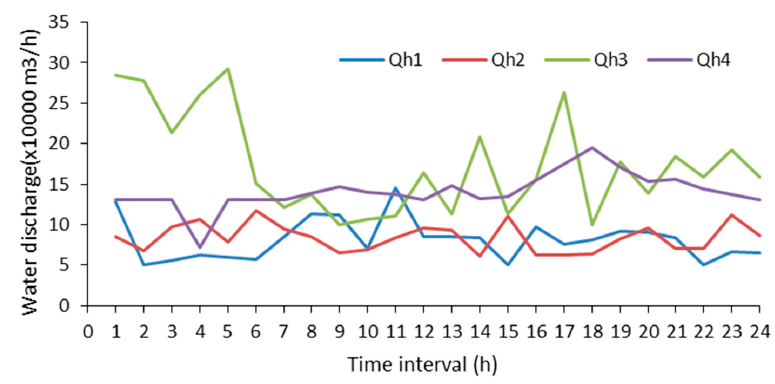
Figure 7. Hydro plant discharge curves.